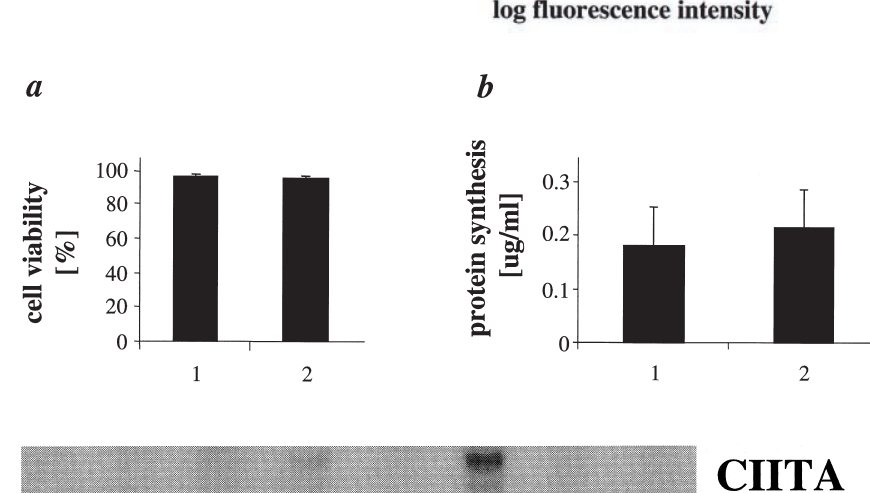
Effect of simvastatin on IFN- γ induced MHC class II expression is mediated by the trans- activator CIITA. RNAse protection assay using probes for MHC class II (DR- α ), CIITA and GAPDH. Human vascular endothelial cells un- stimulated (1), treated with IFN- γ (500 U/ml) alone for 4 hrs (2), 8 hrs (4) or 12 hrs (6), or in combination with simvastatin (10 µ M) for 4 hrs (3), 8 hrs (5) or 12 hrs (7), or treated with sim- vastatin (10 µ M) alone for 12 hrs (8). GAPDH was used as a control for RNA loading. Similar results were obtained in independent experi- ments with ECs from three different